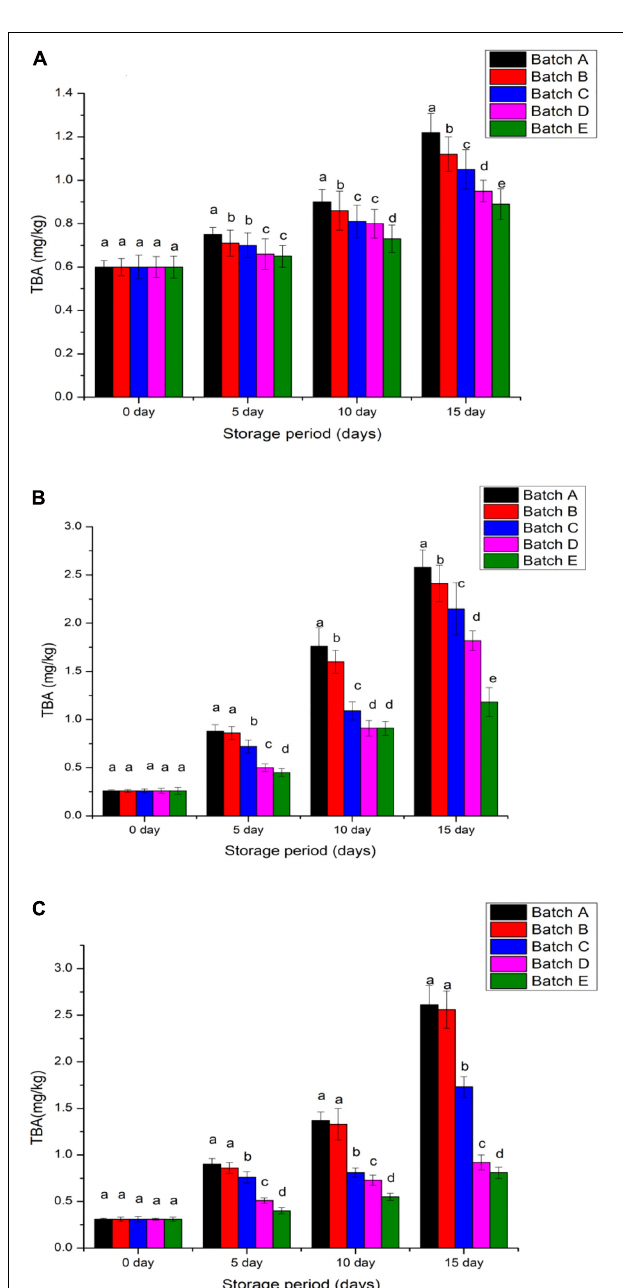
FIGURE 6 | Thiobarbituric acid value of each samples (A) Penaeus merguiensis , (B) Pampus argenteus , and (C) Tenualosa ilisha. Batch A: normal untreated, Batch B: treated with 2% glacial acetic acid, Batches C, D, and E were treated with different types of 2% chitosan solutions (0, 10, and 20 kGy). Value is provided as mean ± SE ( n = 3). The same letters (a–e) over the bar plot stands for insignificant difference ( p > 0.05).